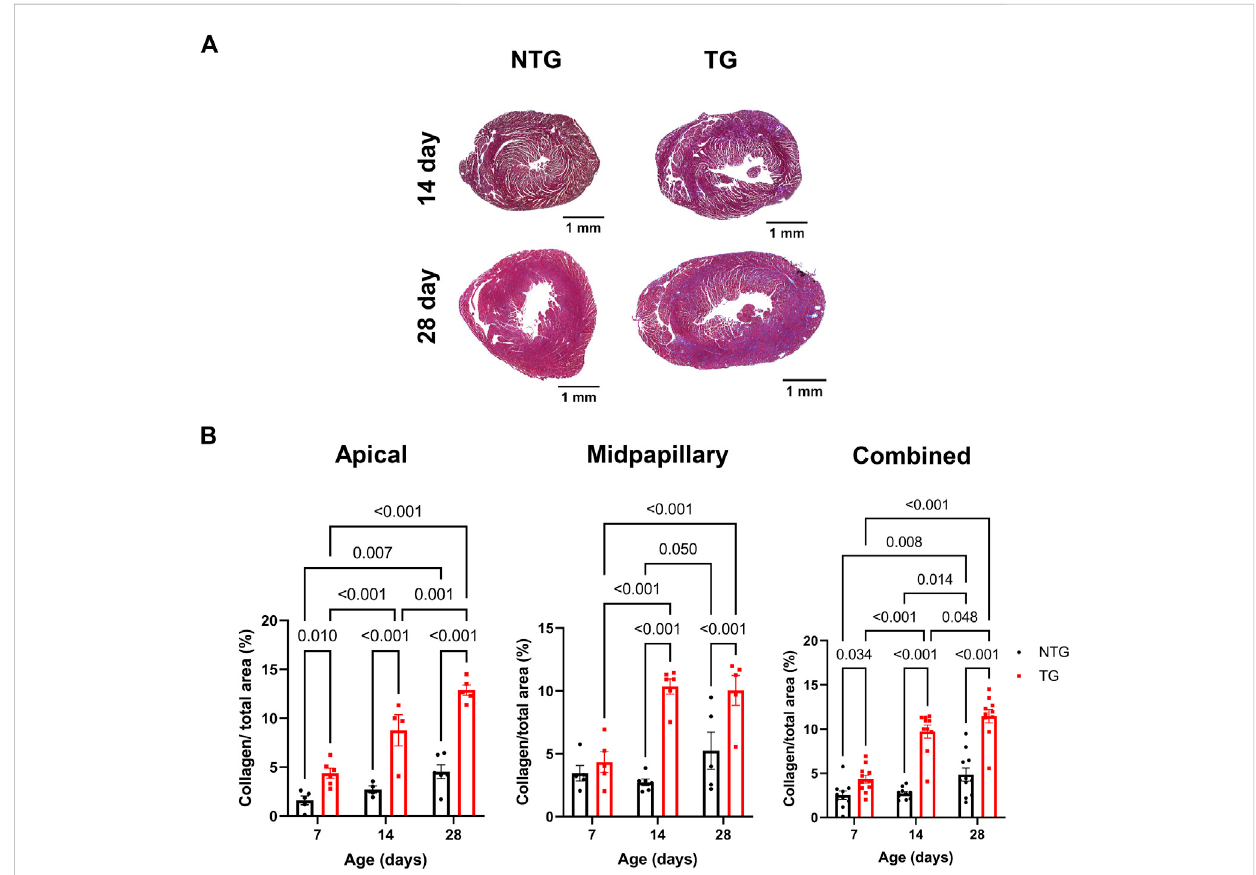
FIGURE 5 Time-dependent changes in fi brosis in apical and midventricular regions of NTG and TG hearts. (A) Representative trichrome-stained midpapillary images of NTG and TG hearts at P14 and P28. (B) Quantitation of collagen deposition presented as % of covered area at P7, P14, and P28 at apical, midpapillary and total (apical and midpapillary regions combined). Data are presented as mean ± SEM. Data were analyzed by 2-way ANOVA followed by Fisher ’ s LSD test; NTG n = 4 – 6, TG n = 5 – 6; NTG, non-transgenic; TG,